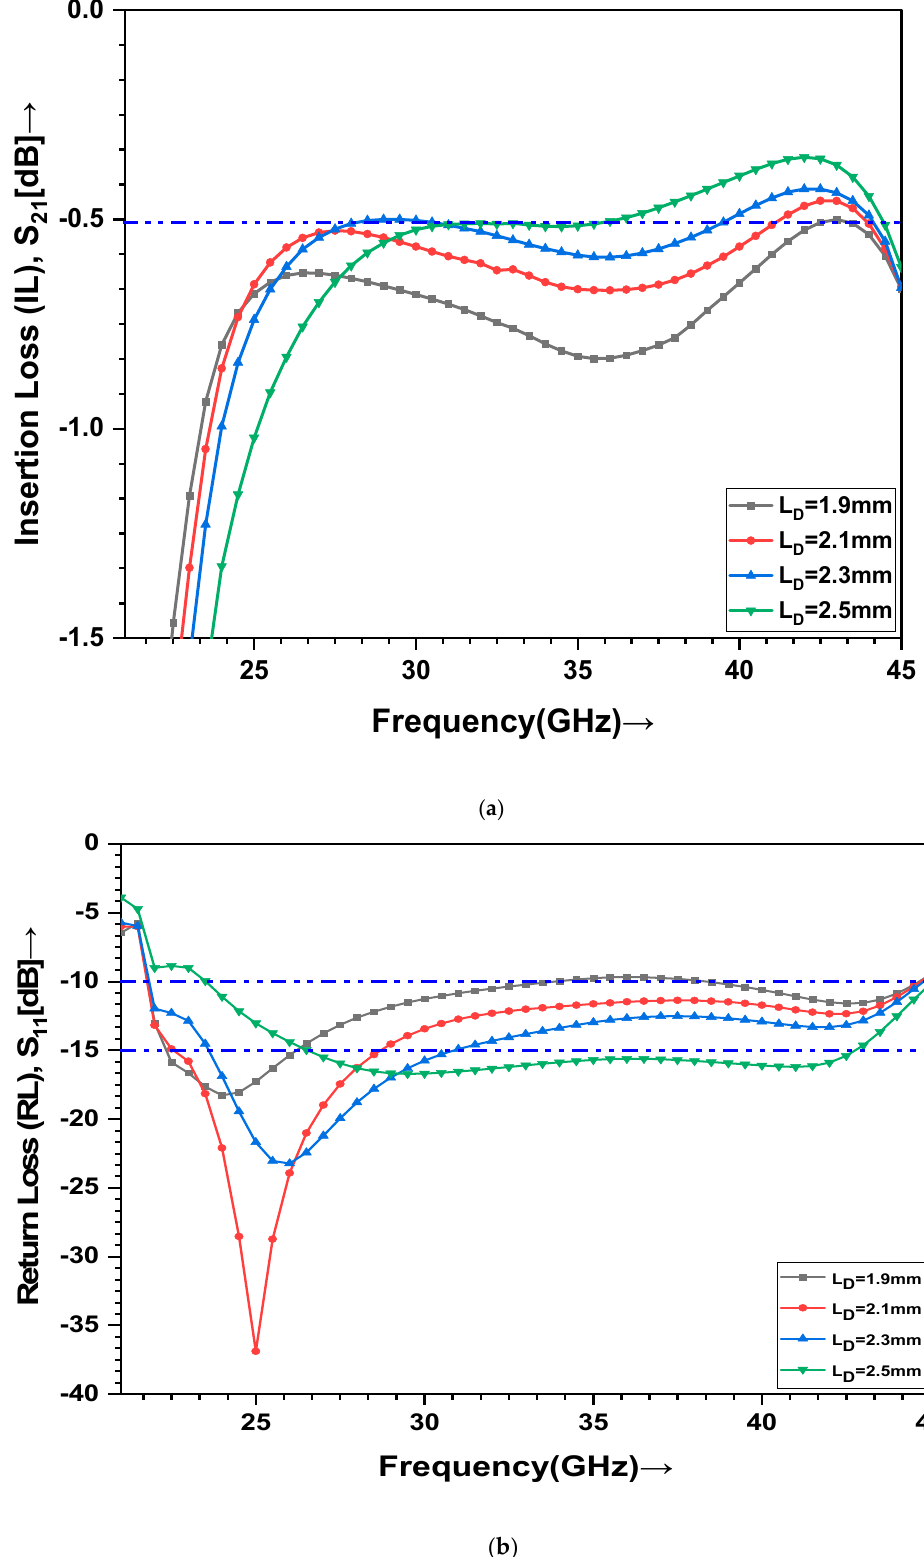
Figure 6. Effect of fishtail depth variations on ( a ) insertion loss, S 21 (dB), ( b ) return loss, S 11 (dB).